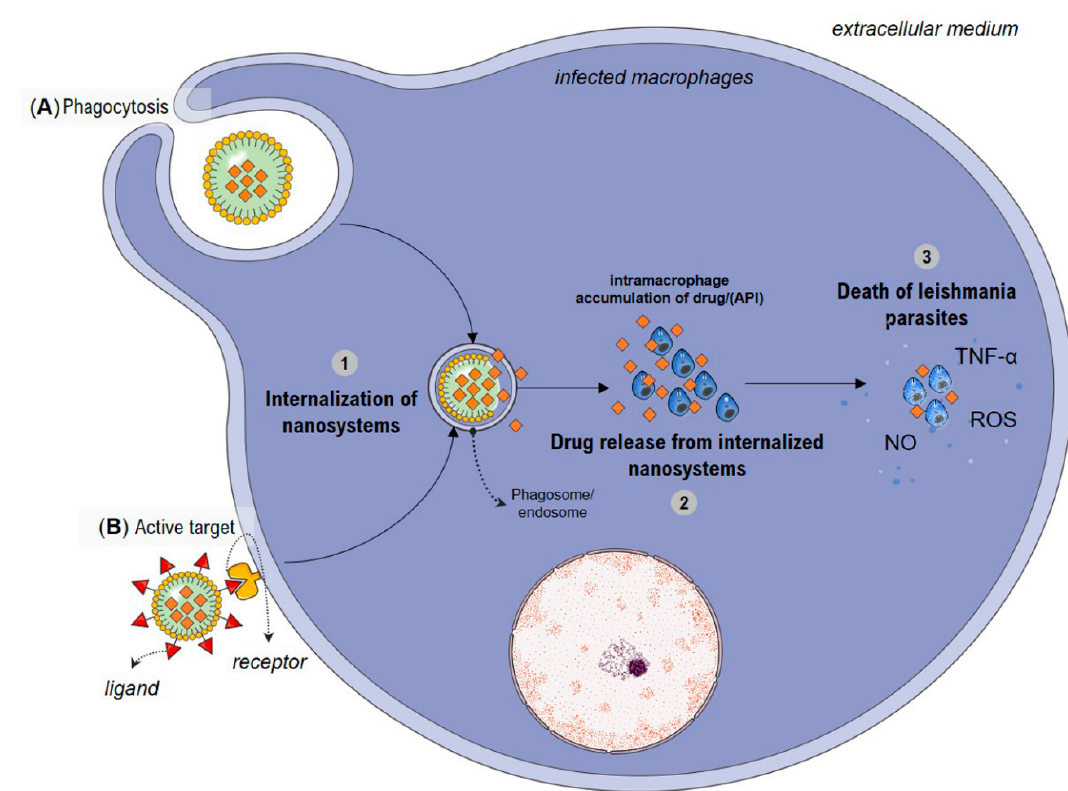
Figure 5. General illustration of possible mechanisms involved with nanosystem-based antileishmanial activity. The enhanced internalization of nanosystems into Leishmania-infected mononuclear phagocytic system cells mediated by ( A ) phagocytosis or ( B ) active target with the aim of achieving selective accumulation inside the cells with release of the active pharmaceutical ingredient (API) promoting a leishmanicidal effect on parasites. Abbreviations: API (active pharmaceutical ingredient); NO (nitric oxide); ROS (reactive oxygen species); TNF- α cytokine (tumor necrosis factor alpha).